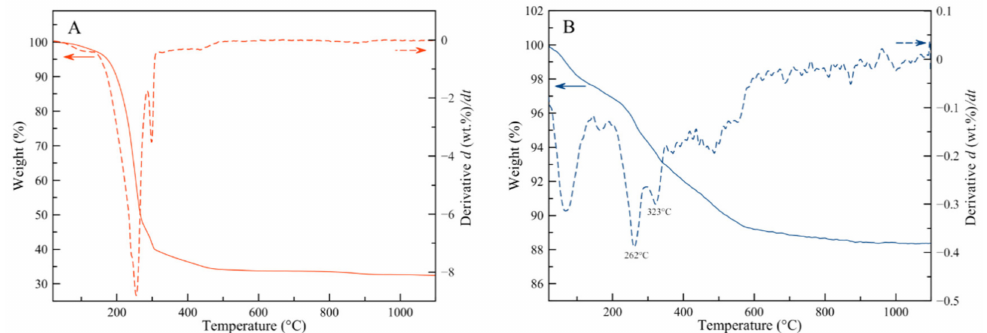
Figure 3. Thermogravimetry analysis (TGA)–derivative thermogravimetric (DTG) curves of ( A ) the freeze-dried toothpaste and ( B ) the water-insoluble fraction.